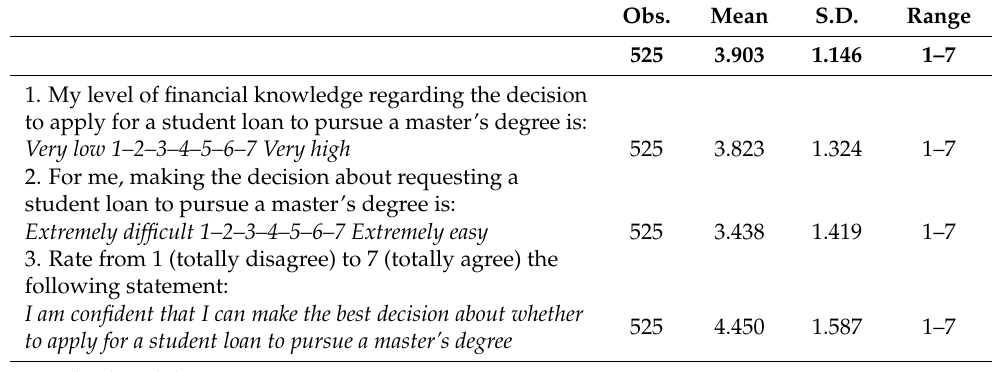
Table 3. The decision to apply for a graduate loan: Perceived financial